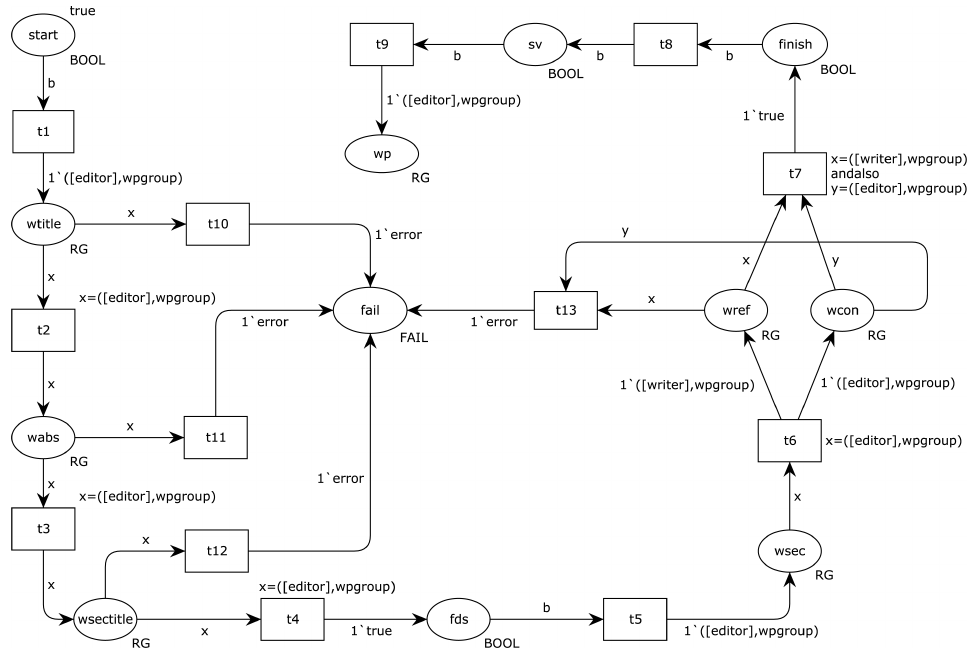
Figure 20. The CPN4M for Writing Paper error example—permission for an agent not eligible for the plan.